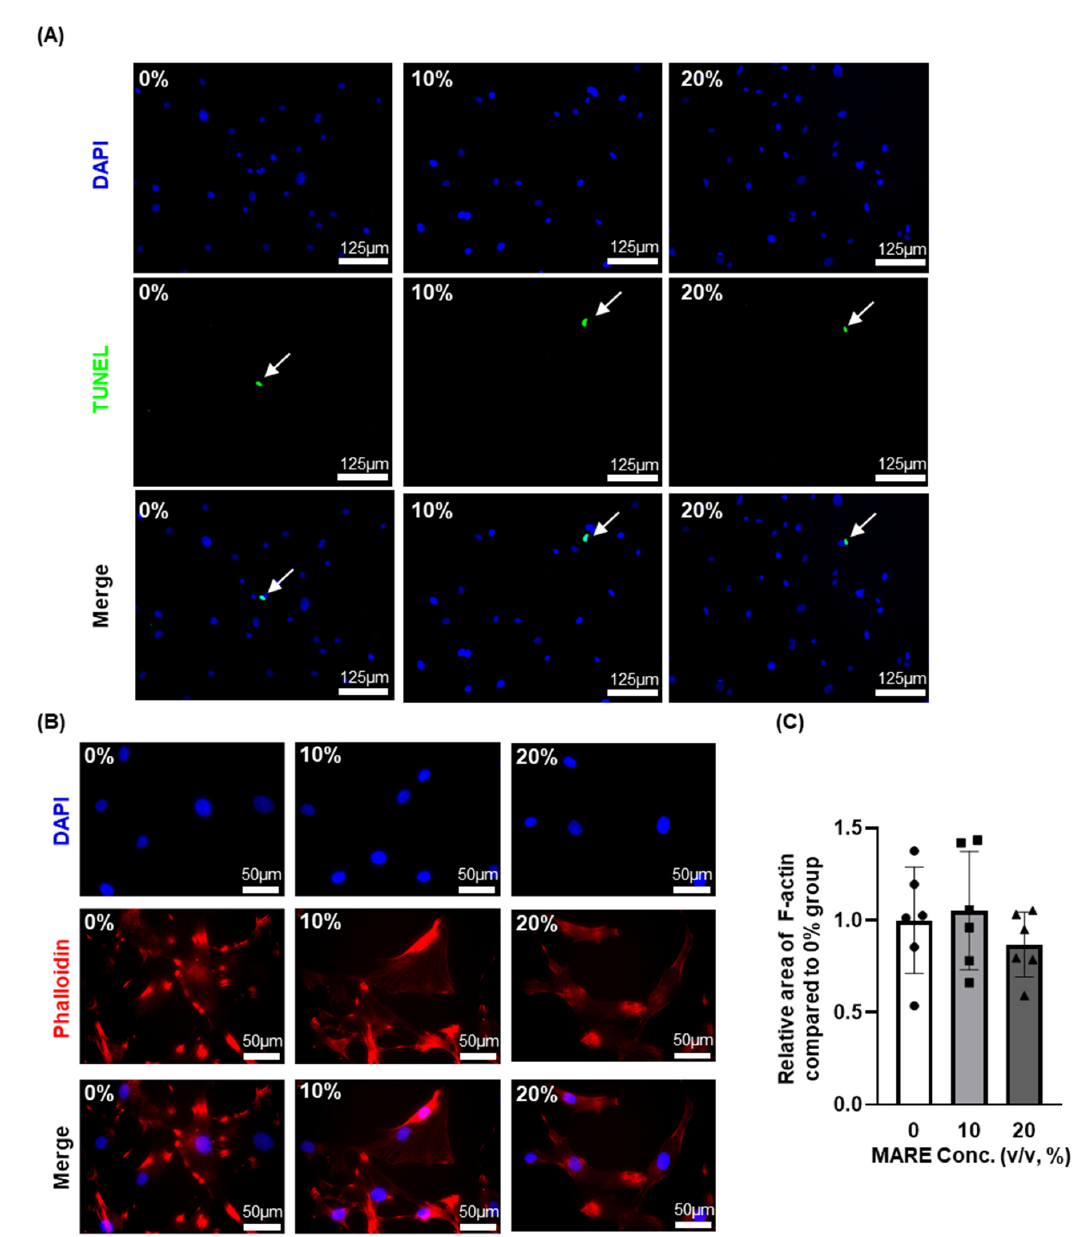
Figure 3. Effect of 0 to 20% concentration of MARE on the HFDPCs. ( A ) Terminal deoxynucleotide transferase-mediated deoxyuridine triphosphate nick-end labeling (TUNEL) assay results of MARE-treated HFDPCs. Cell nucleus was stained with 4 ′ ,6-diamidino-2-phenylindole (DAPI) (blue), and apoptotic cell was stained with fluorescent-dUTP (green, arrow marked). ( B ) DAPI and phalloidin staining results of MARE-treated HFDPCs showing F-actin expression. ( C ) Quantification of F-actin area compared to the 0% group ( n = 6).